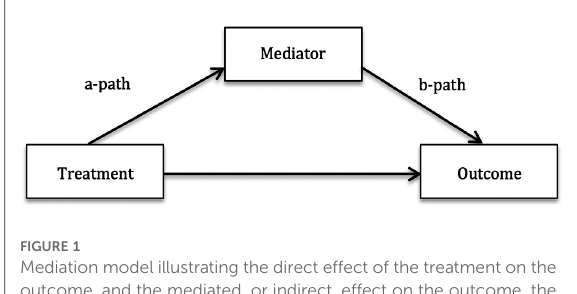
FIGURE 1 Mediation model illustrating the direct effect of the treatment on the outcome, and the mediated, or indirect, effect on the outcome, the ab